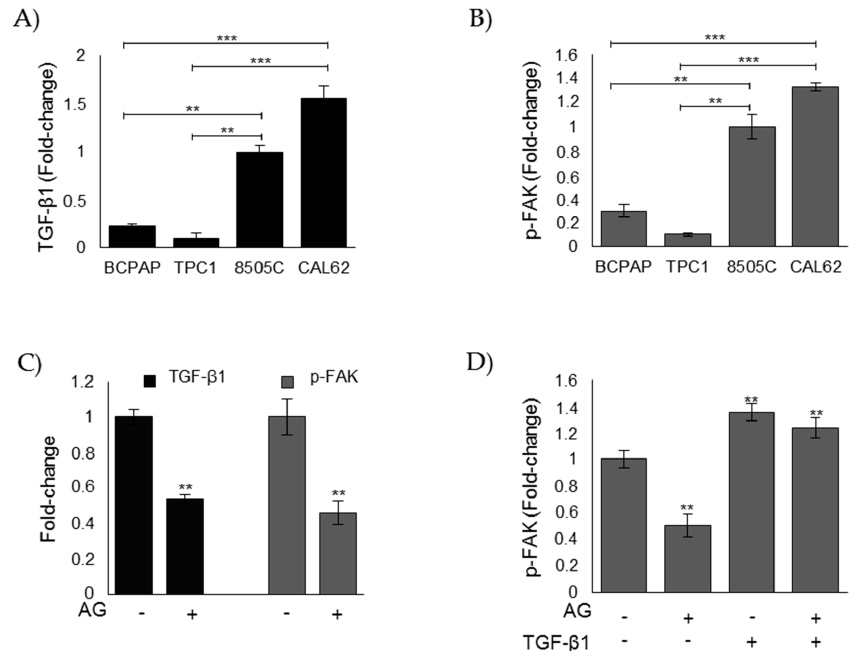
Figure 6. MG sustains the aggressive phenotype of ATC CAL62 cells by modulating TGF- β 1 secretion and FAK signaling. Evaluation of ( A ) secreted TGF- β 1 and phospho-FAK (p-FAK) ( B ) levels, measured by specific ELISA kits in the culture supernatant or lysate, respectively, of PTC (BCPAP and TPC1) and ATC (8505C and CAL62) cell models; ( C ) levels of TGF- β 1 and p-FAK in ATC CAL62 cells treated ( + ) with 1 mM aminoguanidine (AG). Untreated ( − ) cells were used as controls. ( D ) Intracellular levels of p-FAK in ATC CAL62 cells treated with 1 mM AG and / or treated with 5 ng / mL TGF- β 1 for 48 h. The histograms indicate mean ± SD of three di ff erent cultures, and each was tested in triplicate. ** p < 0.01, *** p < 0.001.